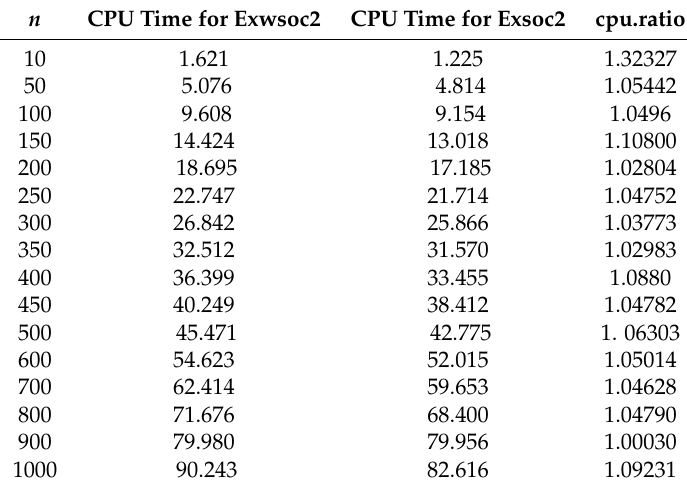
Table 4. CPU times corresponding to Example